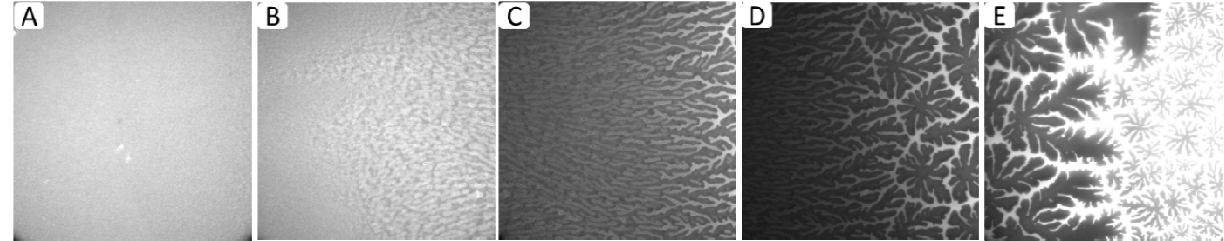
Figure 5. EPI fluorescence micrographs of different regions of a TYPE 1 physisorbed polymer-tethered monolayer illustrating the gradient in terms of buckling structures representative of changes in lipopolymer density: no optically resolvable buckles ( straight-sided blisters ( B ); compartmentalizing buckles ( 160 µm × 160 µm.